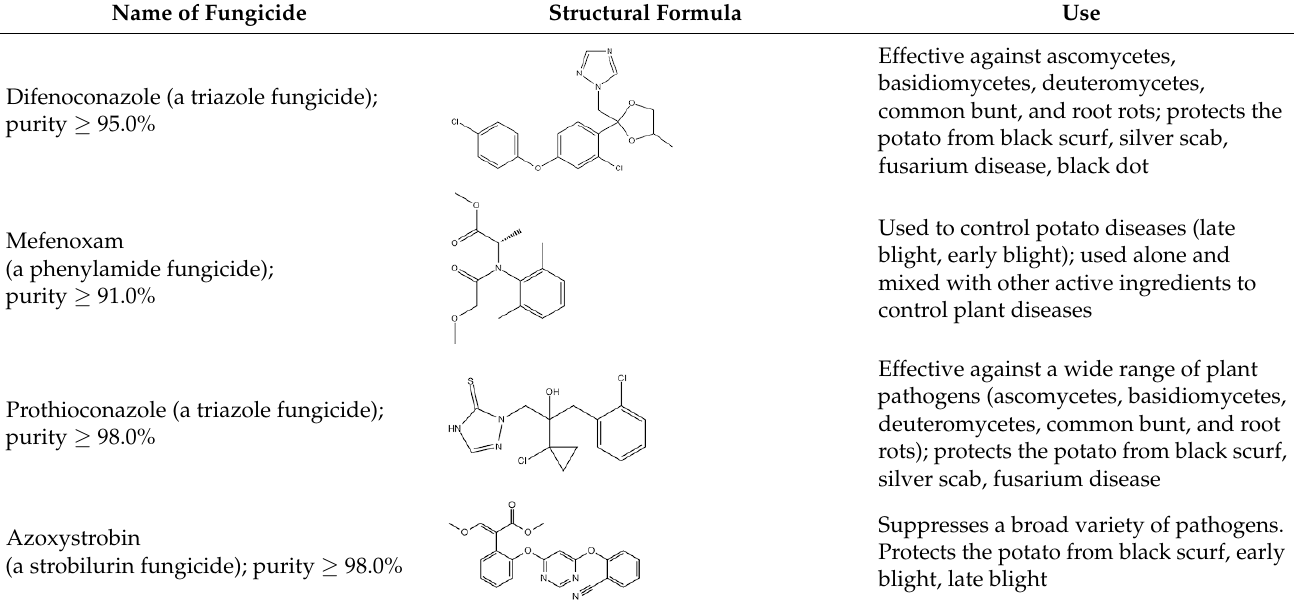
Table 1. Characterization of the fungicides studied [78].